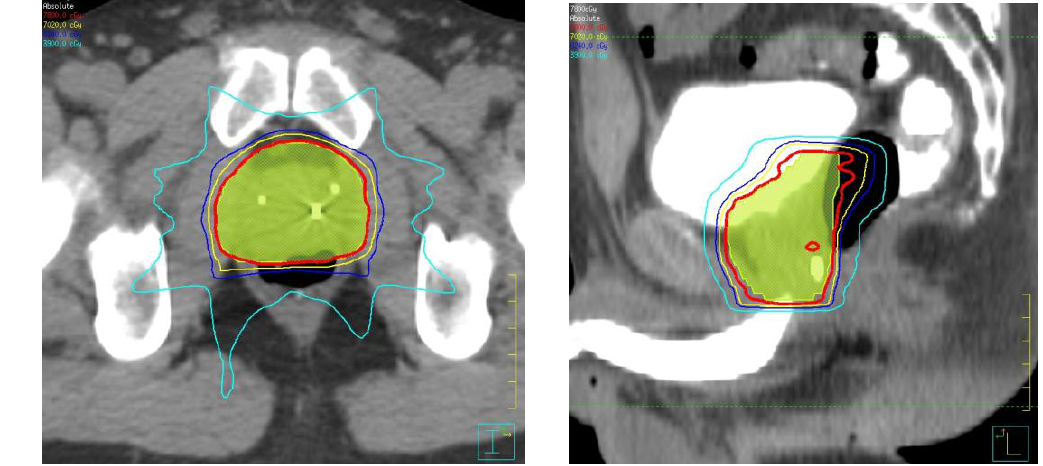
FIGURE 1. Axial and sagittal views, representing the 100% (red), 90% (yellow), 80% (blue), and 50% (aqua) isodose lines of a man treated with IMRT to the prostate to a total dose of 78 Gy. The initial planning target volume, consisting of the prostate and proximal seminal vesicles plus a 5- to 8-mm margin, is shaded